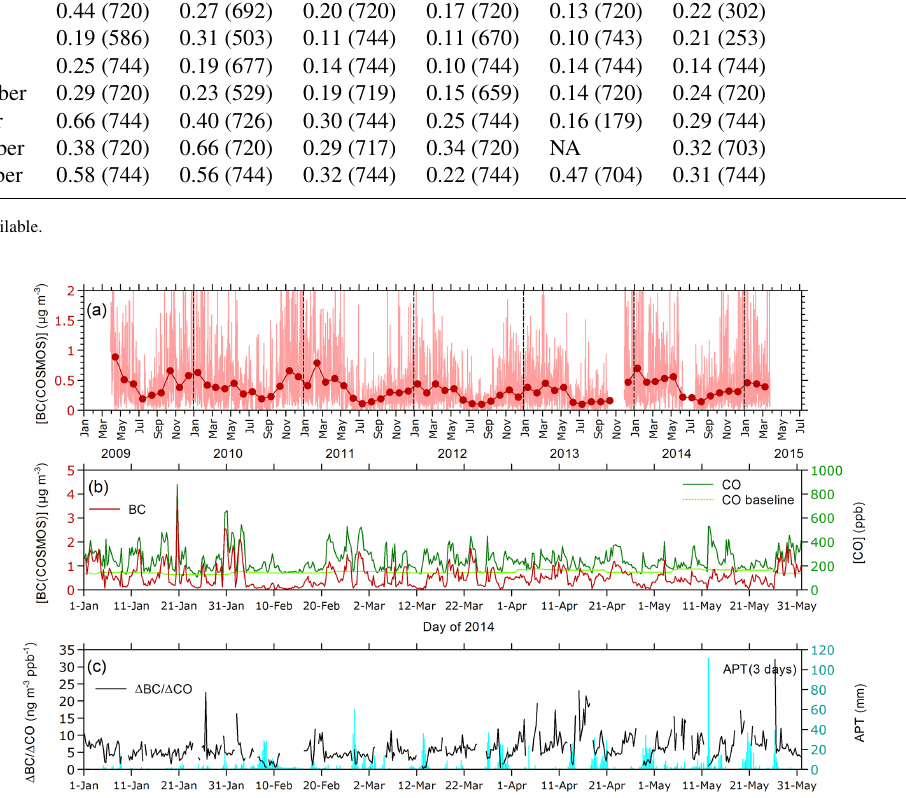
Figure 4. (a) Time series of BC concentrations from COSMOS instrument at Fukue during 2009–2015 (thin line: hourly; dots: monthly averages). (b) and (c) Time series of BC mass concentrations, CO mixing ratios, CO baseline mixing ratios, (cid:49) BC /(cid:49) CO ratios, and